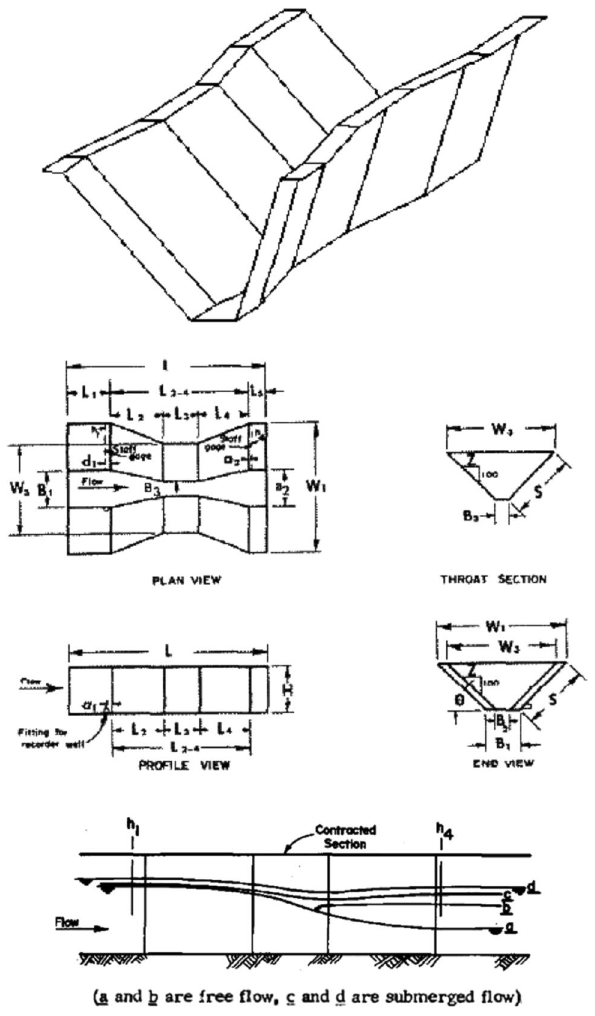
Fig. 2 Overview of trapezoidal flume and its technical specifications